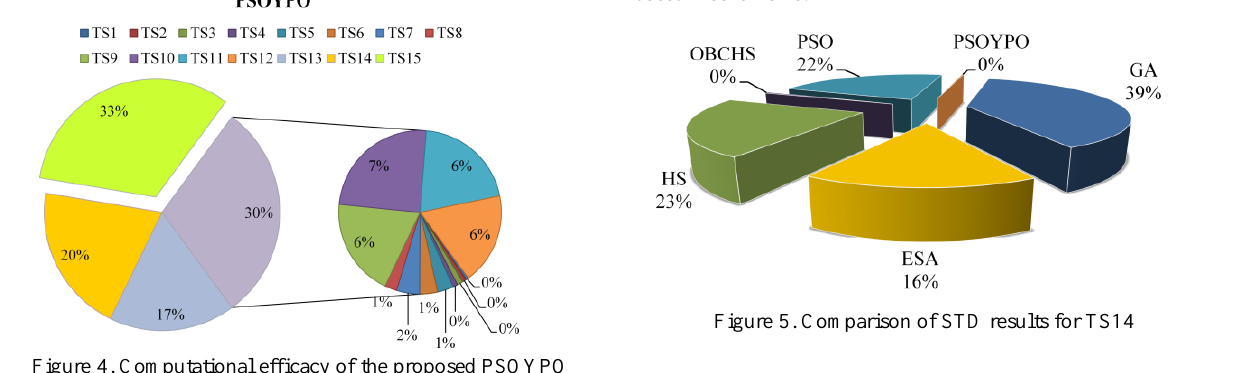
Figure 3. Computational efficacy of the PSO in dealing with TS1 to TS15